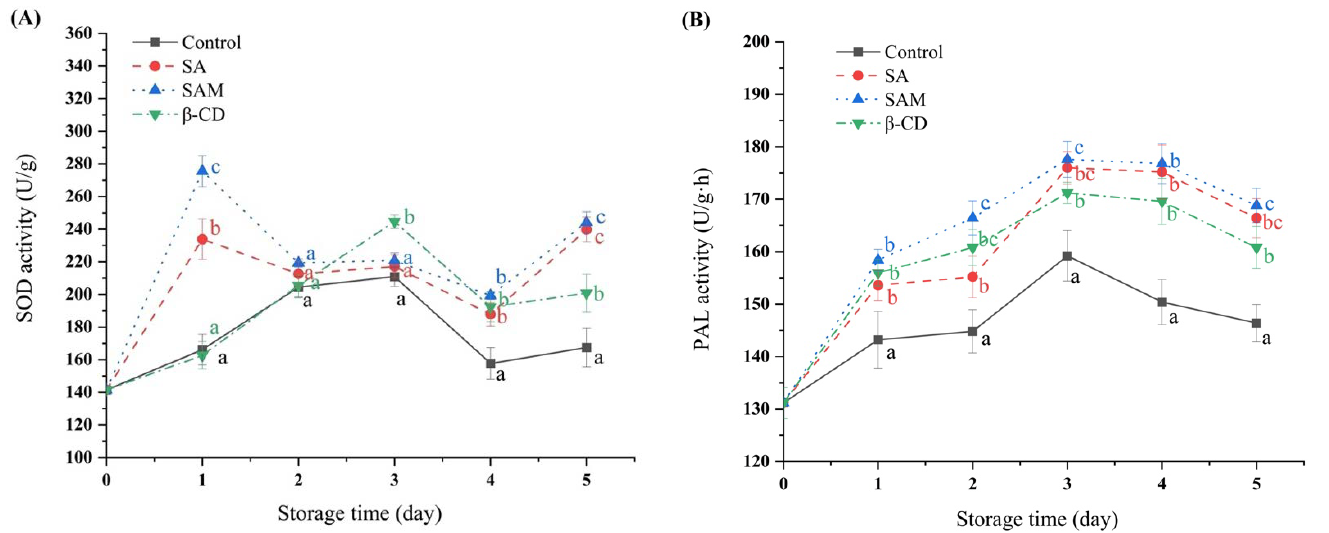
Figure 3. Changes in superoxide dismutase (SOD) ( A ) and phenylalanine ammonia lyase (PAL) ( B ) activities in ‘Fuji’ apple during 5 days of storage at 25 °C. SA, salicylic acid; SAM, salicylic acid microcapsule; β -CD, β -cyclodextrin. Control group was prepared with sterile distilled water. Vertical bars represent standard errors. Different letters within each day show a significant difference ( p < 0.05).